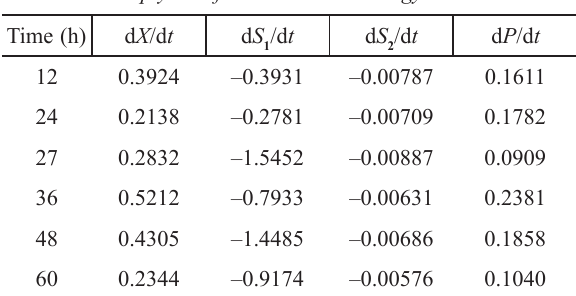
Table 1 – Dynamic rates of A. australica fermentation during empty and fill cultivation strategy Time (h) d X /d t d S /d t 1